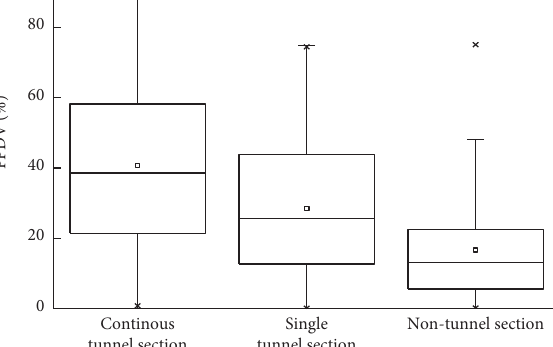
Figure 5: One-way ANOVA of three different road sections.